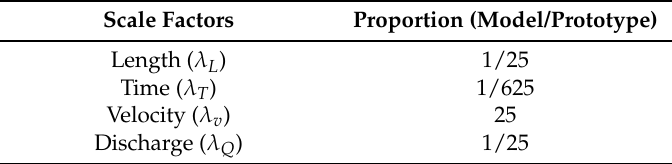
Table 1. Proportions of scale factors of the physical model used in the flume